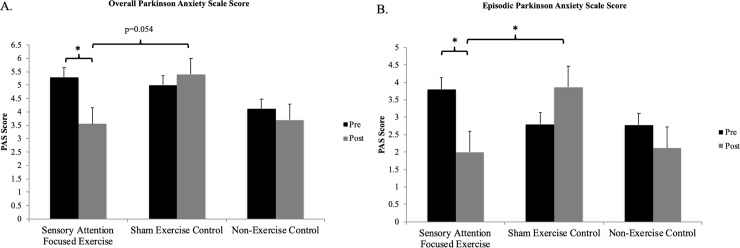
Effect of exercise on anxiety.Reported Overall Parkinson Anxiety Scale (PAS) scores (A.) and Episodic Parkinson Anxiety Scale scores (B.) in participants with Parkinson’s disease before (pre; black) and after (post; grey) 11-weeks of Sensory Attention Focused Exercise, Sham Exercise, or no exercise (non-Exercise Control). Statistical analysis included only exercise groups. * indicates a statistically significant difference p<0.05.